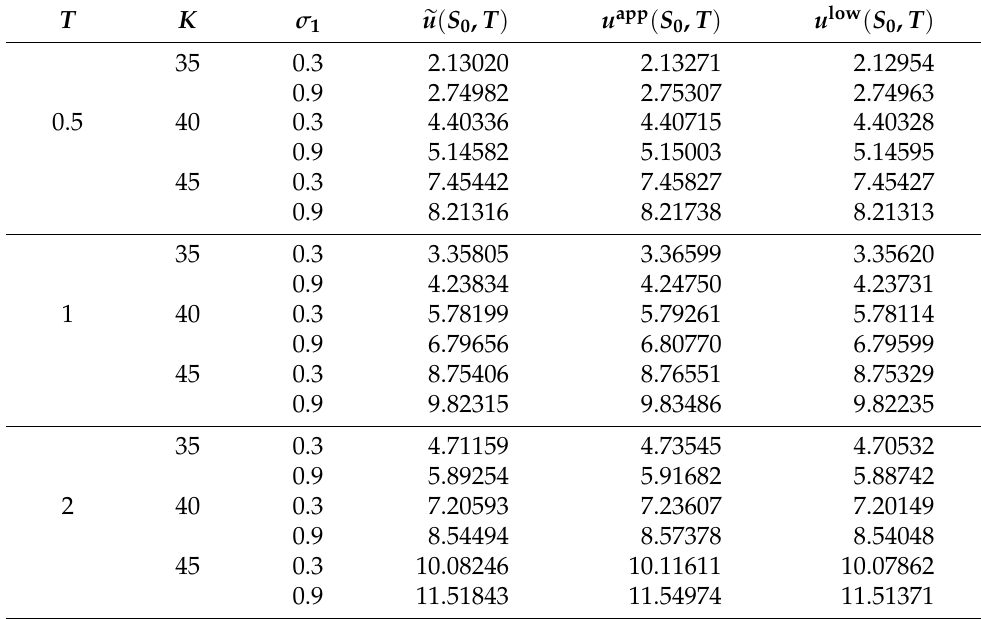
Table 3. Reference values r u p S 0 , T q , u app p S 0 , T q , u low p S 0 , T q for European basket put